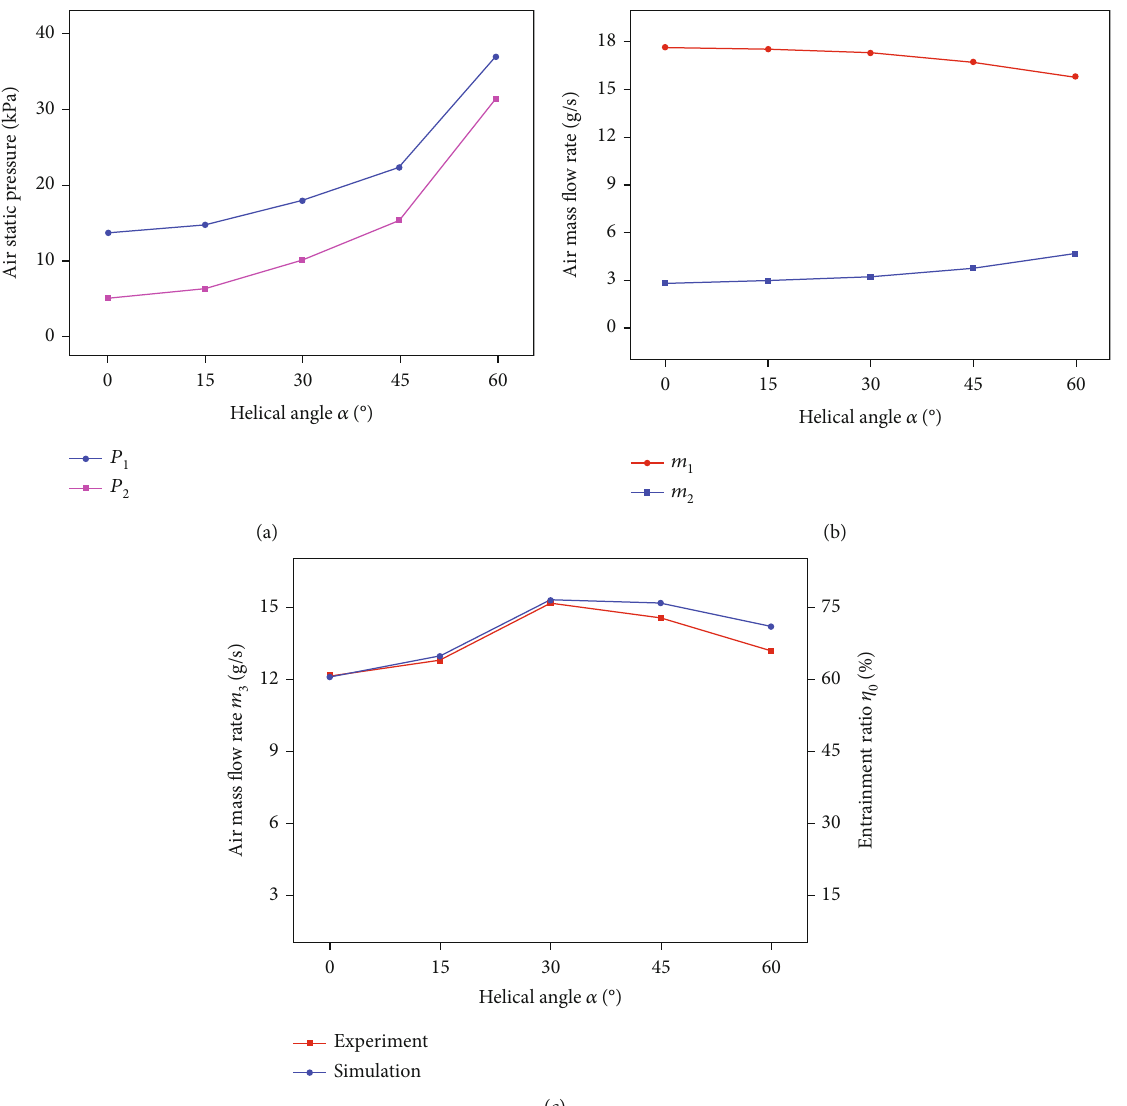
Figure 10: Relationship between helical angle and entrainment performance of drill bit with fl ushing nozzles: (a) static pressure; (b) air mass m fl ow rate m 1 and 2 ; (c) entrainment